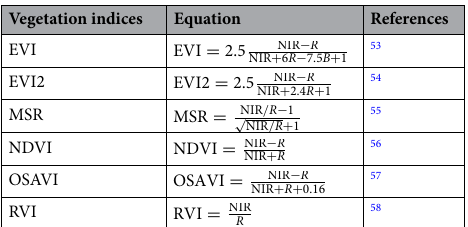
Table 1. Mathematical expressions of various vegetation indexes. R, G, B and NIR represent the reflectance of red, green, blue and near-infrared bands respectively.